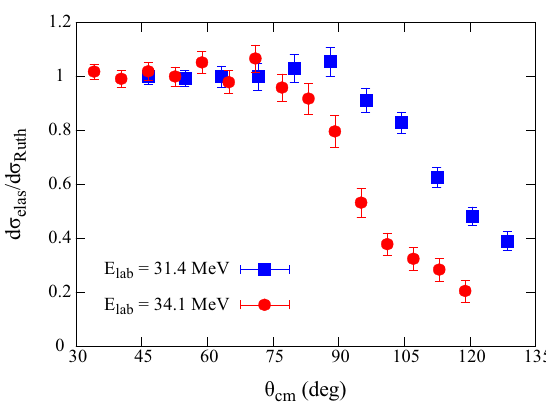
d σ elas Figure 1: as a function of θ cm for 8 Li at E lab = 31.4 MeV and 34.1 MeV. The quoted d σ Ruth energies are the mean 8 Li energies at the centre of the 209 Bi target. These results are prelimi-